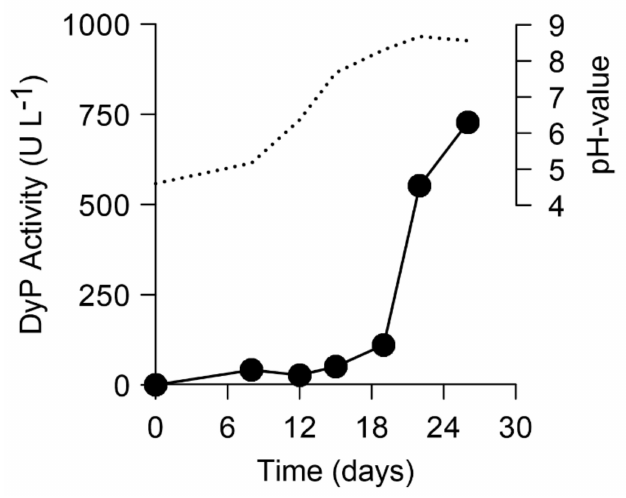
Figure 1. Time course of DyP production (black circles) by X. grammica in SPM medium; activity was measured with ABTS and H 2 O 2 , dotted lines—pH value.